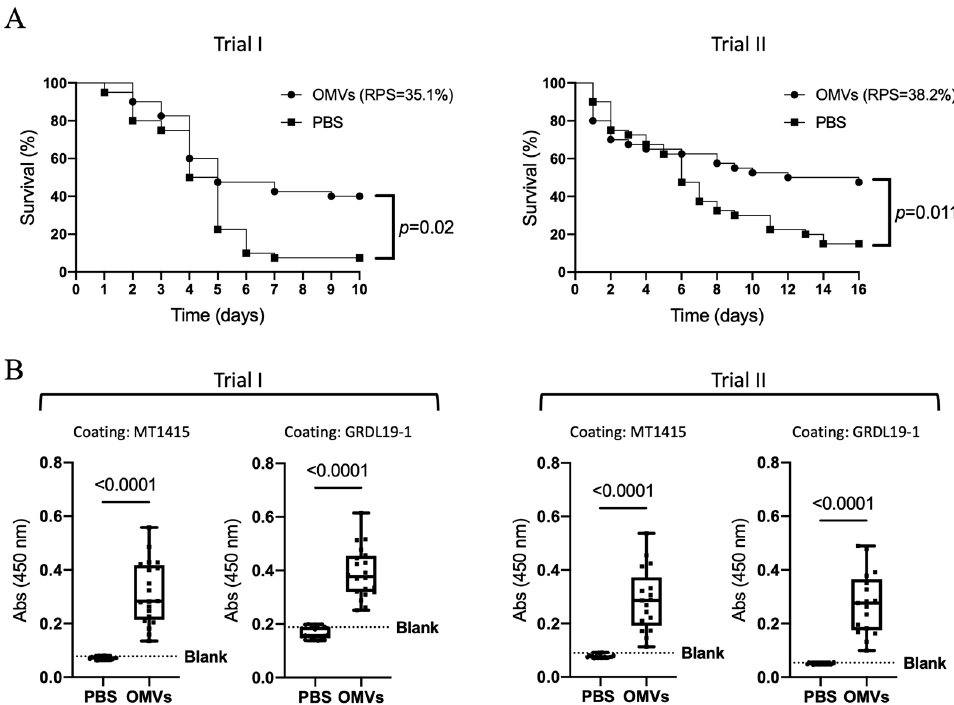
Figure 7. Vaccination with Phdp OMVs confers protection against Phdp infection. ( A ) Kaplan–Meier survival curves of sea bass vaccinated with MT1415 pPHDP10- crude OMVs or injected with PBS ( n = 40 fish/group) and challenged i.p. with Phdp MT1415 . Results obtained in two independent trials (I and II) are shown. Group comparisons were performed by the log-rank test and differences were considered significant when p < 0.05. ( B ) Fish vaccinated with MT1415 pPHDP10- crude OMVs had increased levels of anti- Phdp antibodies. Antibodies against UV-killed bacterial cells from Phdp strains MT1415 or GRDL19-1 were detected by ELISA. Comparisons between antibody levels in sera from vaccinated fish (n = 20 and n = 17 for Trials I and II, respectively) and PBS controls ( n = 20 and n = 19 for Trials I and II, respectively) were performed using the Mann–Whitney test and differences were considered significant when p < 0.05.